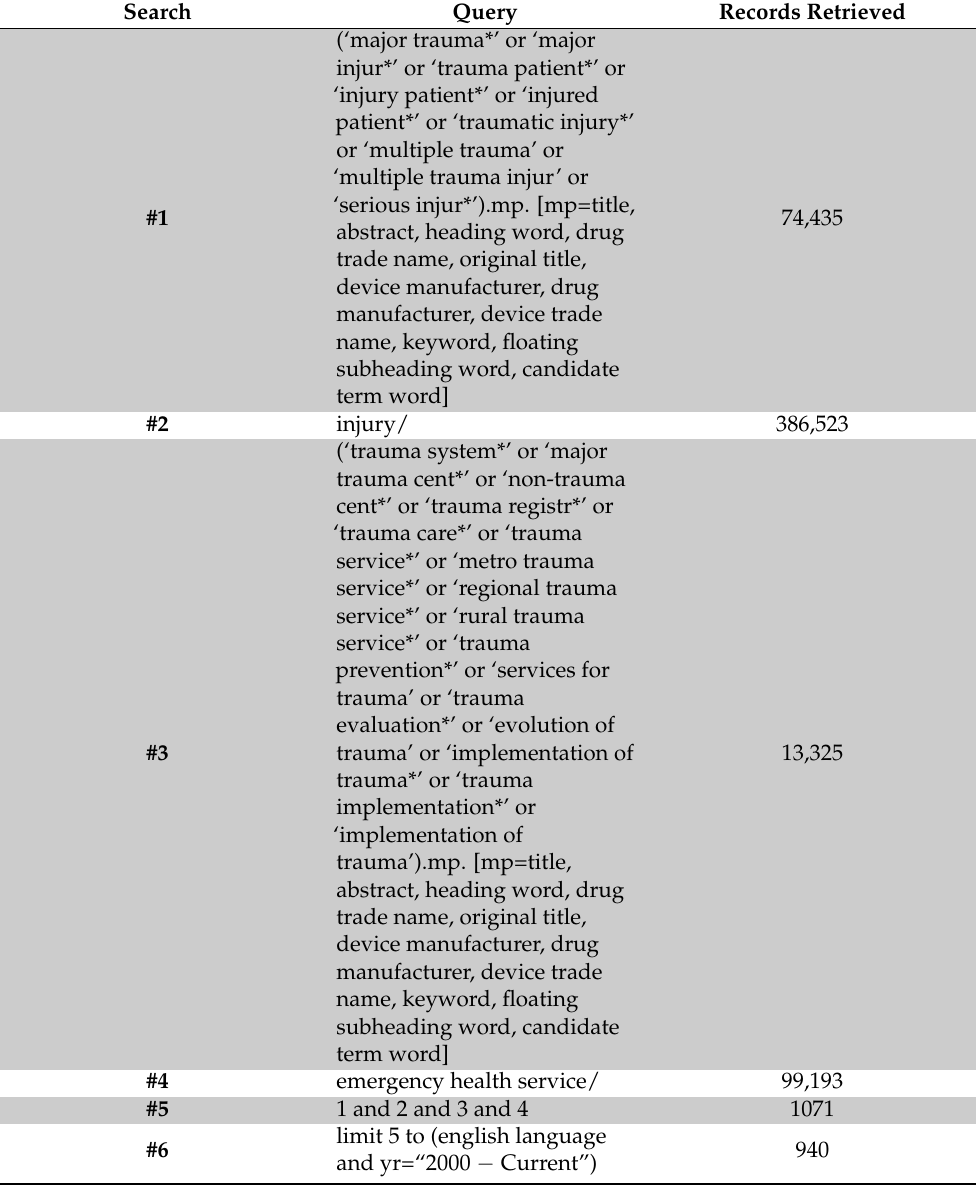
Table A2. Search strategy for EMBASE 1947-present (Ovid). Search conducted: 20 June